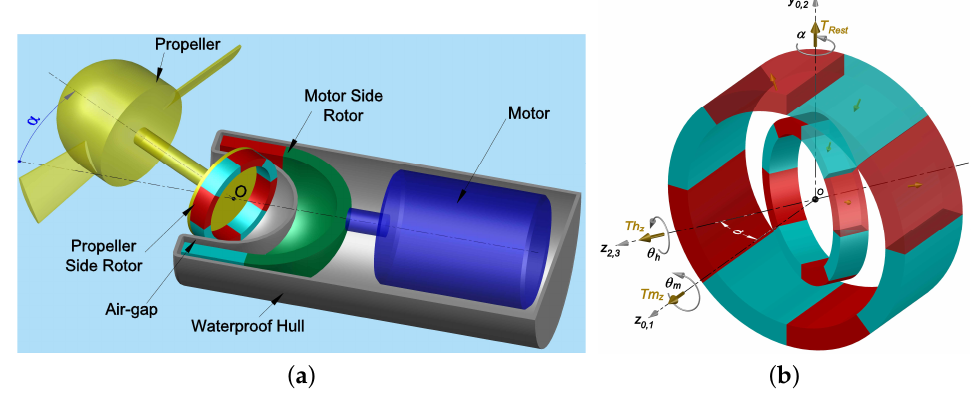
Figure 24. Radial Reconfigurable Magnetic Coupling Thruster (R-RMCT) concept [114]. ( a ) The R-RMCT. ( b ) Only the